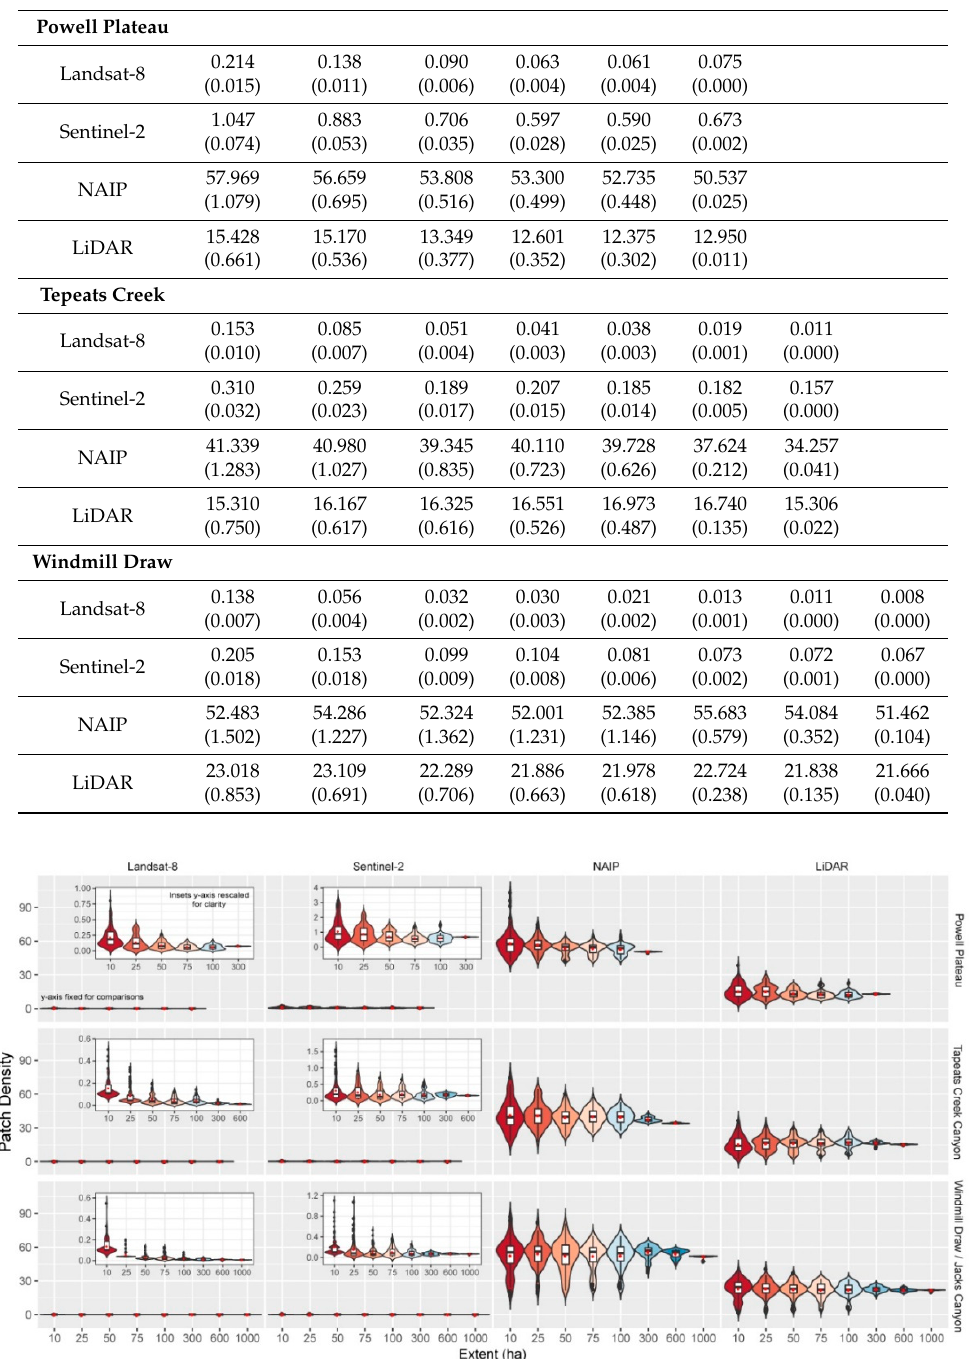
Figure 4. Violin plots (colored by extent and depicting probability density of the data at different values smoothed by a kernel density estimator), box-and-whisker plots (black and white) and mean (red dot) for patch density (patches per ha). Patch density is the number of patches per landscape area under forested canopy cover for each landscape and data product (Landsat-8 30 m, Sentinel-2 10 m, NAIP 1 m, LiDAR 1 m), and across multiple spatial extents. Insets with rescaled y-axis provided for clarity. Table 4. Mean Patch Area (MPA) (ha), the average area composed of patches of canopy cover, across each landscape and data product (Landsat-8 30 m, Sentinel-2 10 m, NAIP 1 m, LiDAR 1 m), and across multiple spatial extents. Mean values and standard error (SE) are shown. Mean Patch Area (ha)